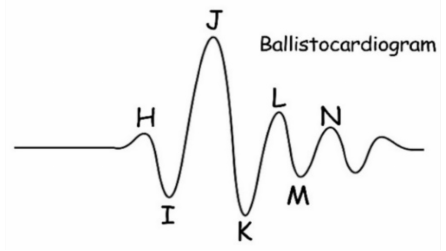
Figure 3. An example of BCG waveform. Table 1. Comparison of performance between BCG and